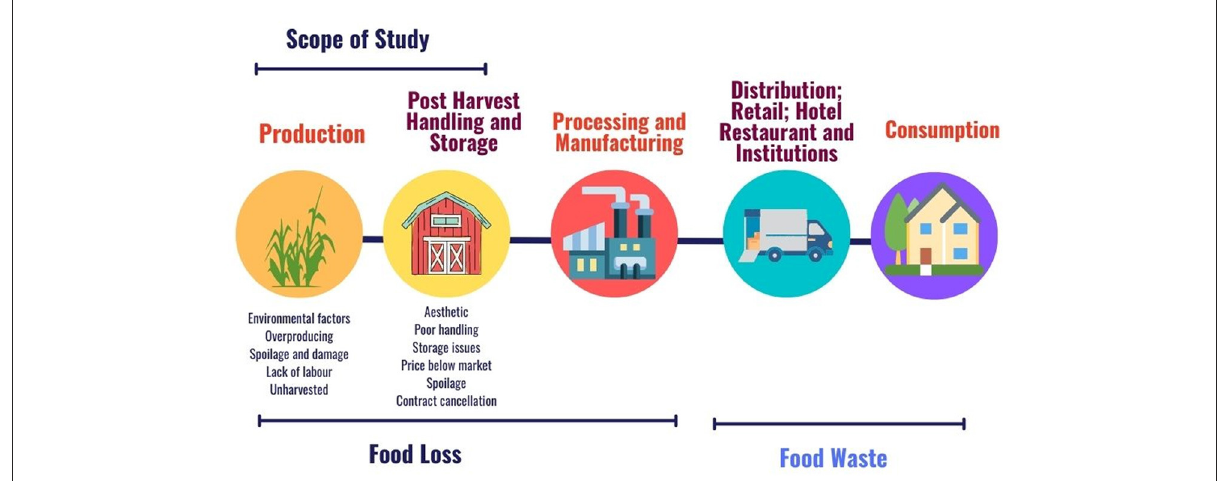
FIGURE6 Scope of the study food loss and waste diagram [adapted from Nikkel et al.